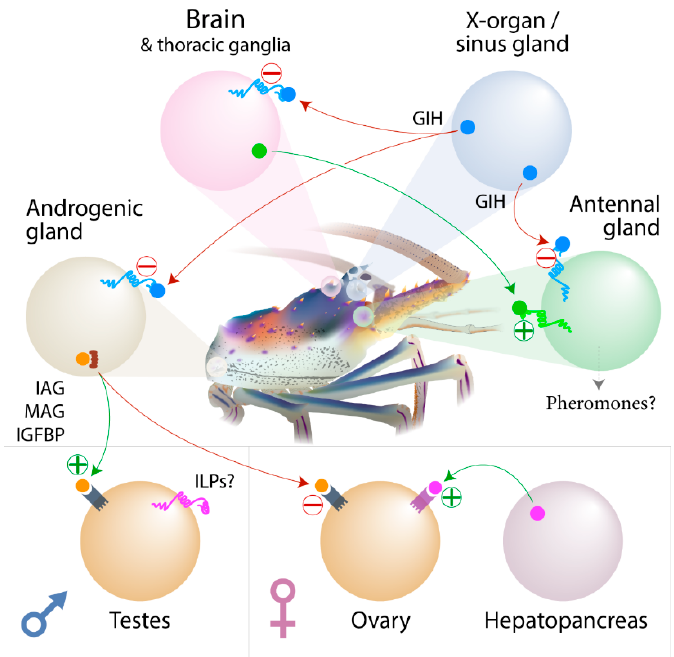
Figure 6. Proposed model for decapod sexual development molecular interactions . The predicted sexual development system in decapod crustaceans involves the gonad inhibiting hormone (GIH—blue), which is secreted from the x-organ–sinus gland complex and inhibits the release of gonadotropins from the central nervous system (brain and thoracic ganglia). These gonadotropins (plausibly red pigment concentrating hormone (RPCH), GPA2/B5, or crustacean female-specific hormone (CFSH)—green) then bind receptors on target cells to stimulate reproductive capacity in the gonads and potentially also the antennal gland (where they potentially stimulate pheromones production and release). The GIH potentially inhibits this directly. The decapod equivalent of vertebrate sex steroids, secreted by the gonads in response to the gonadotropin stimuli, is yet to be elucidated, with ecdysteroids suggested as candidate parallels. The gonad-specific kinase we identified in two spiny lobster species is a potential downstream effector of IAG, joining multiple other factors identified as candidates for further research to better understand sexual development in decapods. The male-specific iDMY is conserved between the eastern and ornate spiny lobsters ( S. verreauxi and P. ornatus ), indicating a conserved central function in sex